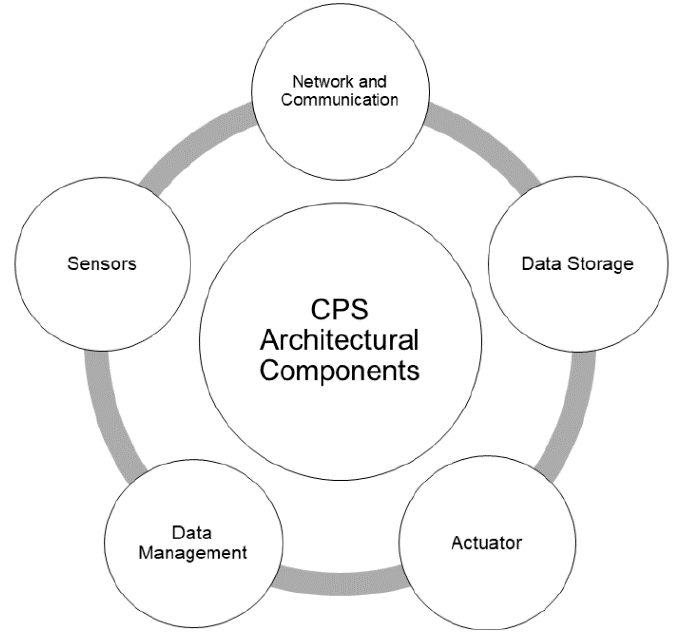
Figure 3. Architectural components of Cyber Physical Systems (CPS).